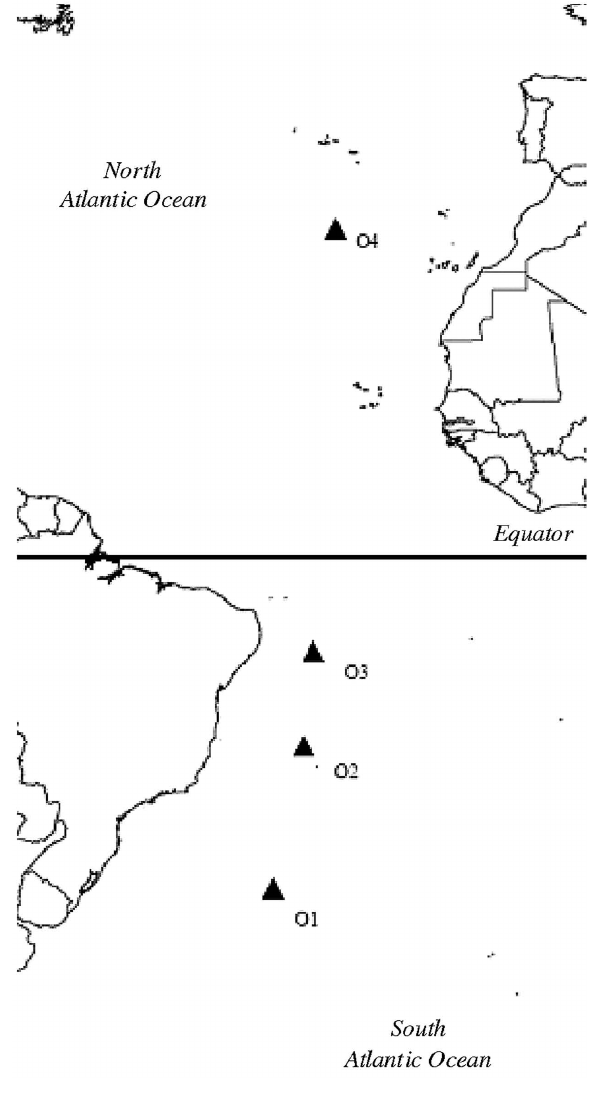
Fig . 2. – Geographic locations of oceanic sampling